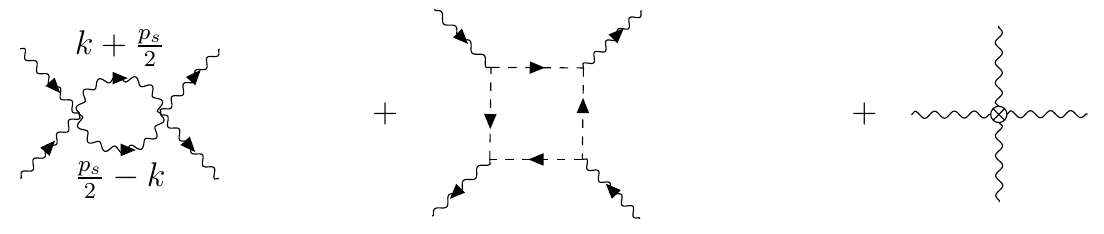
Figure 8 . Wavy line represents σ propagator and the dashed line represents φ I